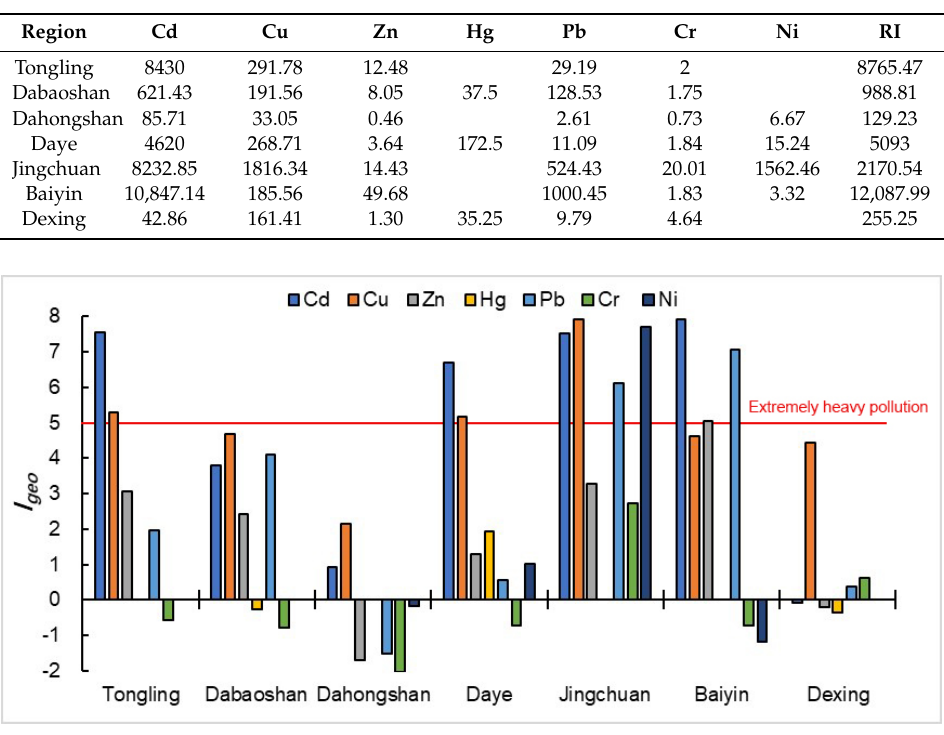
Figure 2. Geoaccumulation index of sediments in rivers surrounding typical copper mines. Int. J. Environ. Res. Public Health 2020 , 17 , x FOR PEER REVIEW